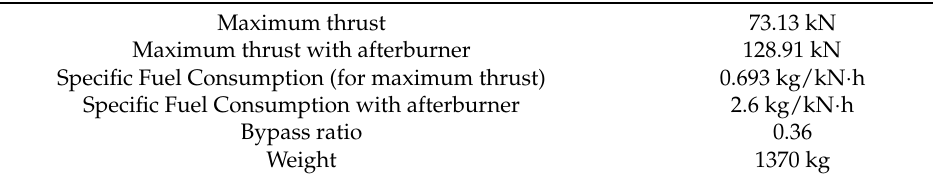
Table 1. Technical specification of the F100-PW-229 engine.